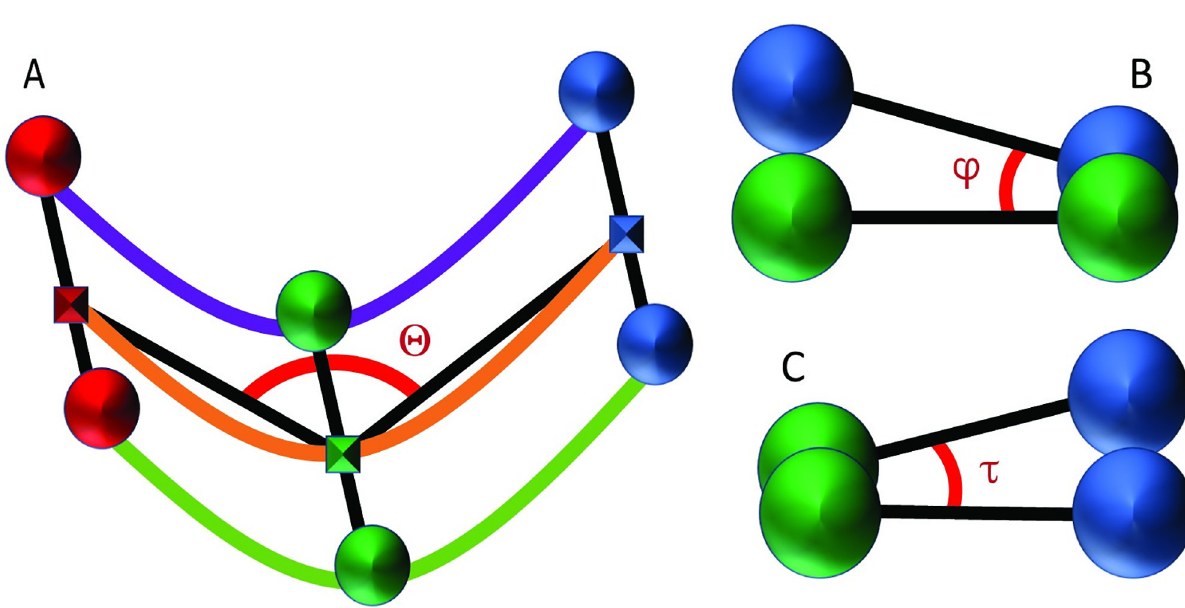
Fig 8. Hypergraphical geometric features contextualize seam cell assignments. Anatomically inspired geometric features describe bend and twist of a posture assignment. A: Three pairs of sequential nuclei: red, green, blue. Rectangles represent pair midpoints. The angle Θ in red is used as a degree six feature given six nuclei assignments. B, C: Degree four hypergraphical features measuring twist angles φ and τ . These angles measure posterior to anterior twist pair-to-pair and left-right twist, respectively.